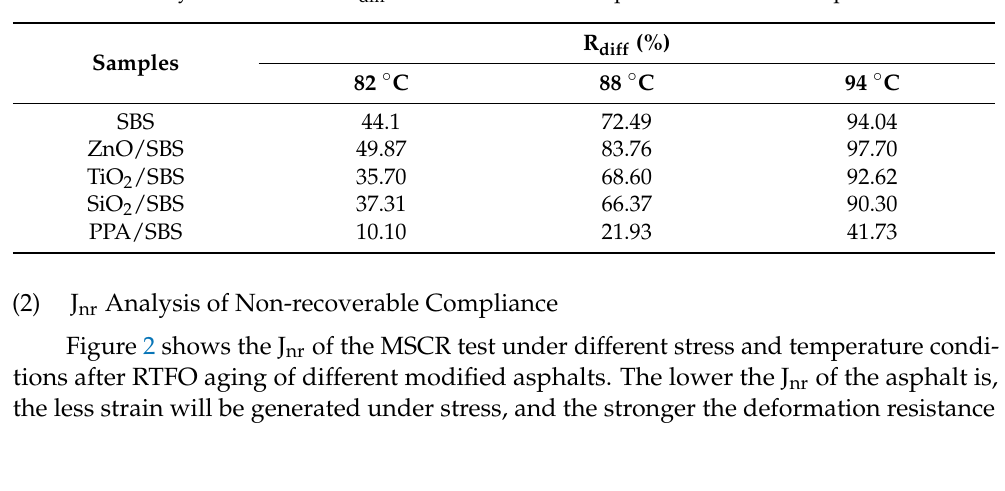
Table 2. Recovery rate difference R diff of various modified asphalts at different temperatures. Samples